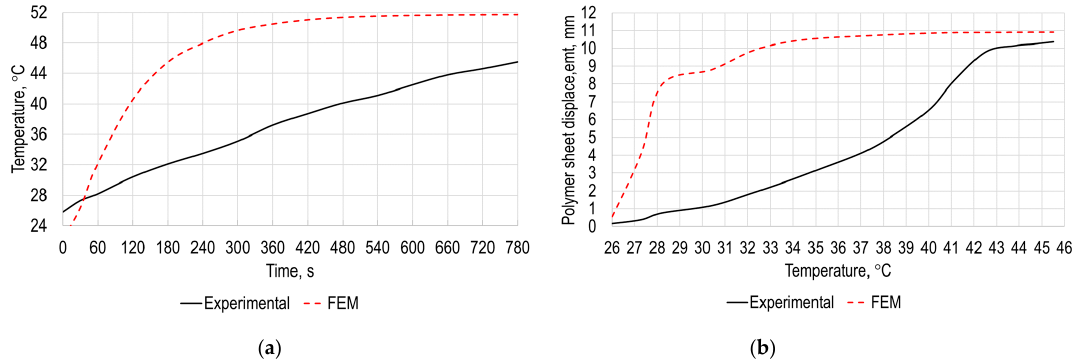
Figure 8. Experimental validation results: ( a ) polymer sheet temperature versus time; ( b ) polymer sheet displacement versus temperature.